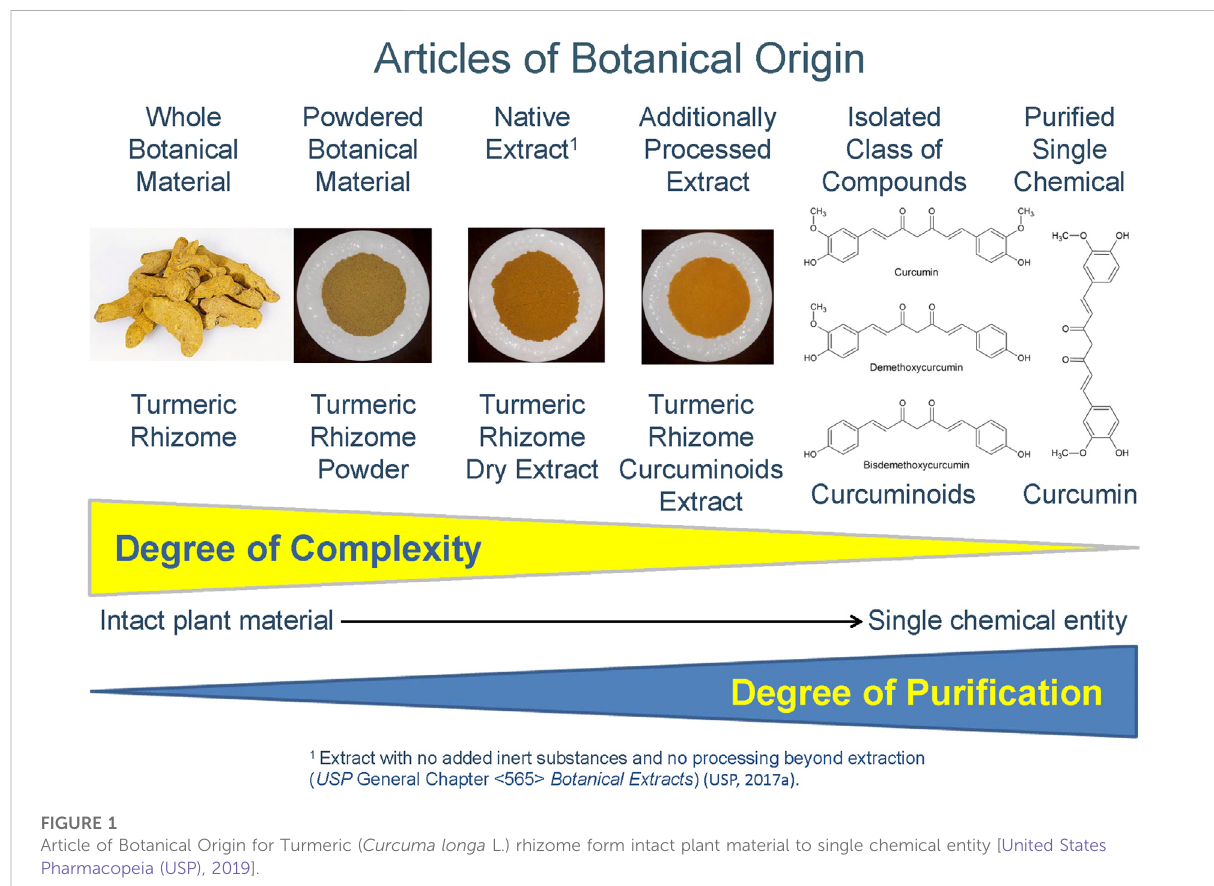
FIGURE 1 Article of Botanical Origin for Turmeric ( Curcuma longa L.) rhizome form intact plant material to single chemical entity [United States Pharmacopeia (USP),